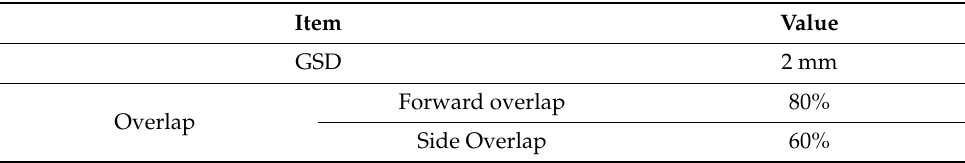
Table 5. First test scenario for the validation of the simulator.